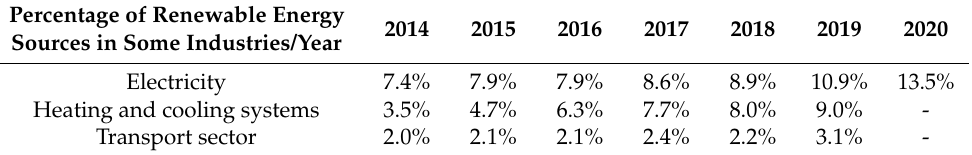
Table 4. Actual values of renewable energy facilities in Ukraine 2014–2020 [24].